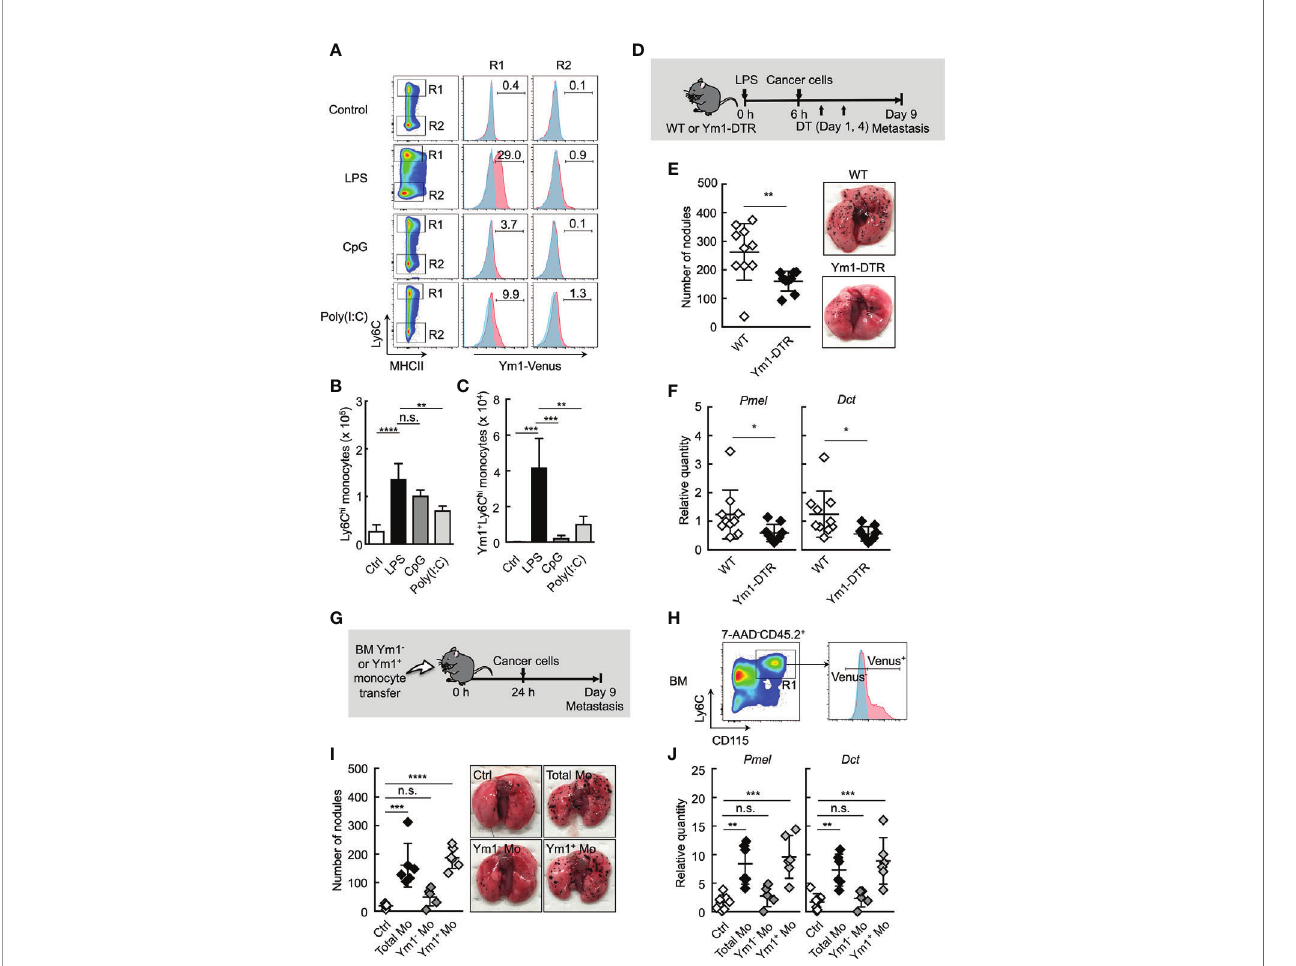
FIGURE 2 | Ym1 + Ly6C hi monocyte subset plays a vital role in lung metastasis. (A – C) Flow cytometric analysis of the lung cells in WT- (shaded area in blue) or Ym1- Venus mice (in red). PBS (Ctrl), LPS, CpG, or Poly(I:C) was injected intravenously into WT- or Ym1-Venus mice. Forty-eight hours later, lung cells were stained for CD45.2, CD11c, CD11b, Ly6G, MHCII and Ly6C, and analyzed by fl ow cytometer as described in Supplemental Figure 1A . Numbers indicated percentage of Ym1 + cells in CD45.2 + CD11c - CD11b + MHCII - Ly6C hi cells (R1; Ly6C hi monocytes) or CD45.2 + CD11c - CD11b + MHCII - Ly6C low cells (R2; Ly6C low monocytes) (A) . Absolute numbers of Ly6C hi monocytes (B) and Ym1 + Ly6C hi monocytes (C) in lungs. Average values are shown with SD. One-way ANOVA followed by Dunnett ’ s test, n = 3-5. **** P < 0.001; *** P < 0.005; ** P < 0.01; n.s., not signi fi cant. (D – F) Reduced number of lung metastases in the absence of Ym1 + Ly6C hi monocytes. (D) Experimental design used to test the contribution of Ym1 + cells to metastatic progression. WT- and Ym1-DTR mice were injected intravenously with LPS. Six hours later, B16 cells were injected intravenously, and this was followed by the i.p. injection of DT (500 ng/injection) on Days 1 and 4. The lungs were analyzed for metastasis on Day 9. (E) Quantitative summary of the number of metastases in lungs (left), and representative images of lung metastasis (right). (F) mRNA expression levels of indicated genes in lungs are shown as fold change relative to lung of DT-treated WT mice. Average values are shown with SD. Unpaired two-tailed t-test, n = 9-10. ** P < 0.01; * P < 0.05. Each symbol represents an individual animal. (G – J) Increased number of lung metastases in Ym1 + Ly6C hi monocyte-transferred mice. (G) Experimental design used to test the effects of transfer of Ym1 + or Ym1 - Ly6C hi monocytes (Ym1 + Mo or Ym1 - Mo, respectively) on metastatic progression. Ym1 + Ly6C hi and Ym1 - Ly6C hi monocytes were sorted from BM of Ym1-Venus mice 48 h after LPS (20 µg) treatment. WT mice were transferred intravenously with advanced RPMI1640 medium (Ctrl), Ym1 + Mo or Ym1 - Mo (5 x 10 5 cells). Twenty-four hours later, B16 cells (1 x 10 5 cells) were injected intravenously. The lungs were analyzed for metastasis on Day 9. (H) Identi fi cation of Ym1 + Mo or Ym1 - Mo in BM for cell sorting. Samples were pregated on live CD45.2 + cells. (I) Quantitative summary of the number of lung metastases (left), and representative images of the lungs metastasis (right). (J) mRNA expression levels of indicated genes in lungs are shown as fold change relative to control lungs. Average values are shown with SD. One-way ANOVA followed by Dunnett ’ s test, n = 5-7 (I and J). **** P < 0.001; *** P < 0.005; ** P < 0.01; n.s., not signi fi cant. Each symbol represents an individual